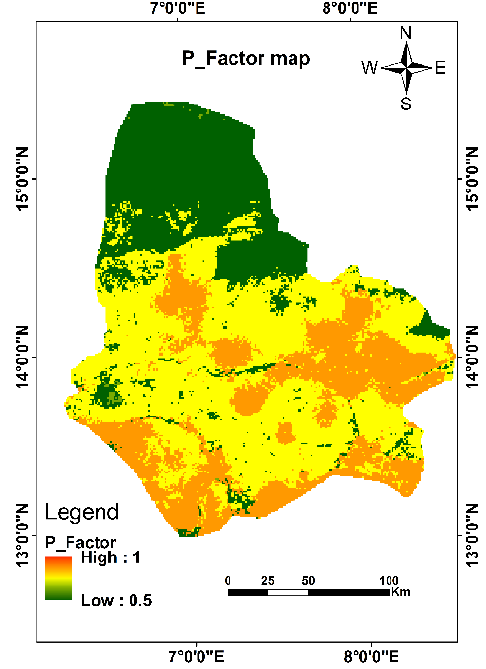
Figure 7. The conservation practice (P-factor).